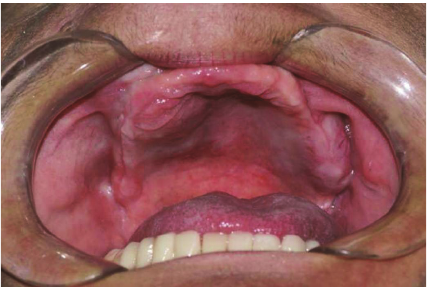
Figure 1: Clinical intraoral presentation at time of the first appoint-